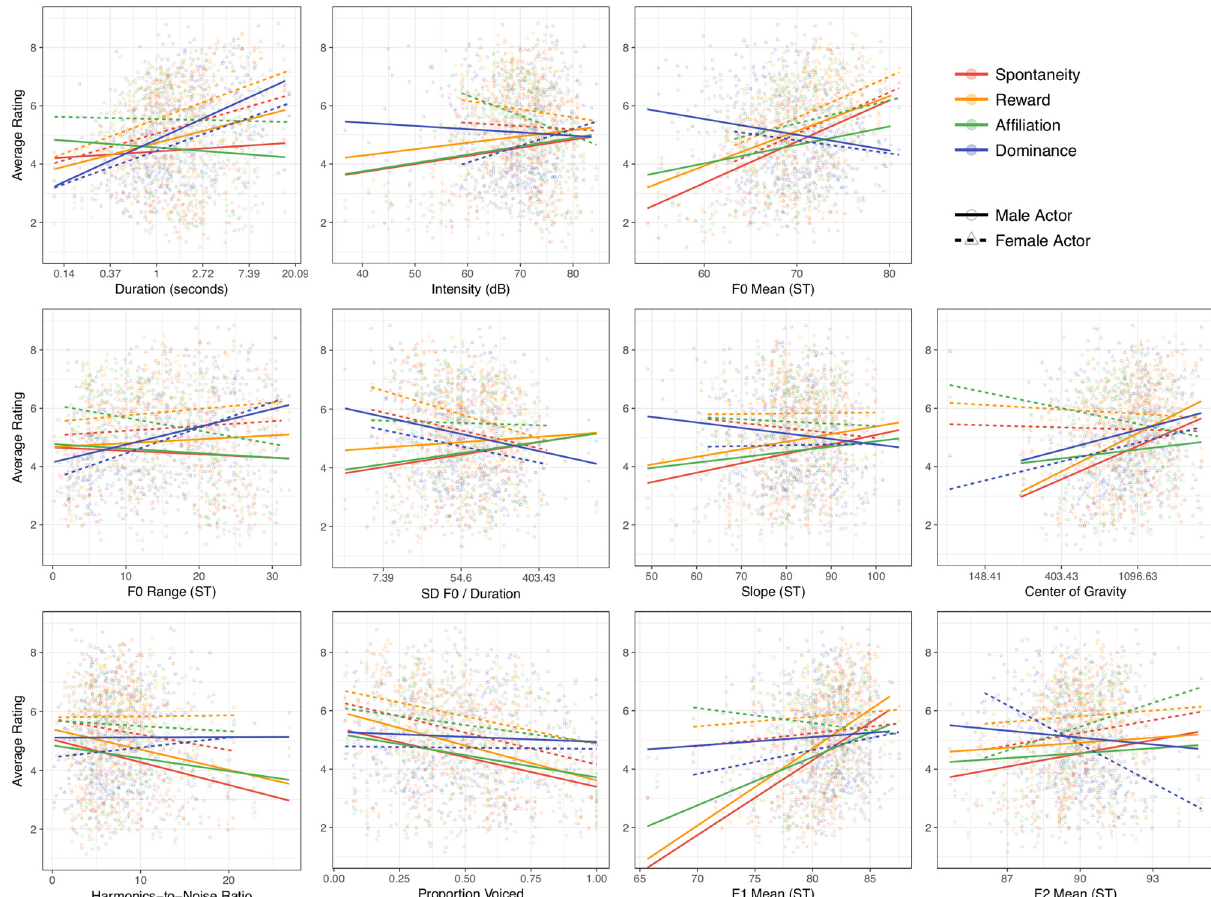
Fig 1. The relationship between laugh samples’ acoustic measuresand averageparticipant ratings, separated by actor sex, fitted with ordinary least squares regression. Footnotes . Each point is a single laugh sample’saveragescore for a given social judgment. Y axes are the degreeto which participants thought the description of each social dimensionfit the laugh (1 = not at all, 10 = very much). X-axis tick marks for log-transformed variablesare non-linearbecausethey have been convertedback to the originalunit of measure. ST indicatesa pitch variablethat has been convertedto the semitonescale. Since the plotted regressionlines are from simple regressions, they may not perfectly match the coefficients from the reportedLMEMs in Table 4.